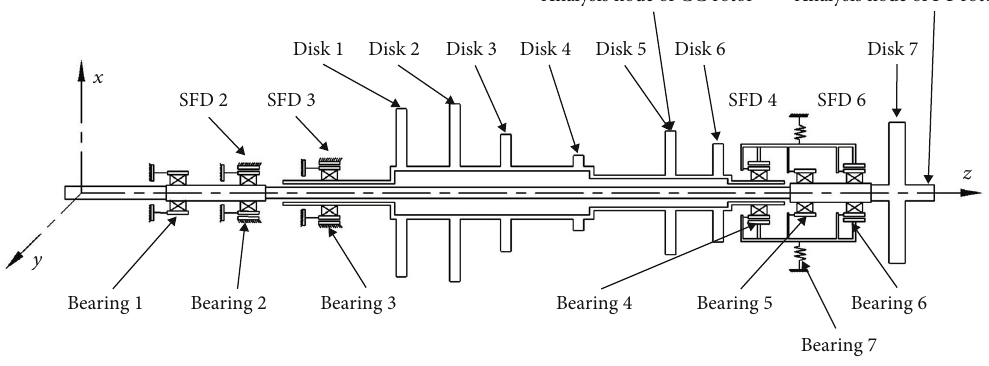
Figure 5: Simpli fi ed analysis